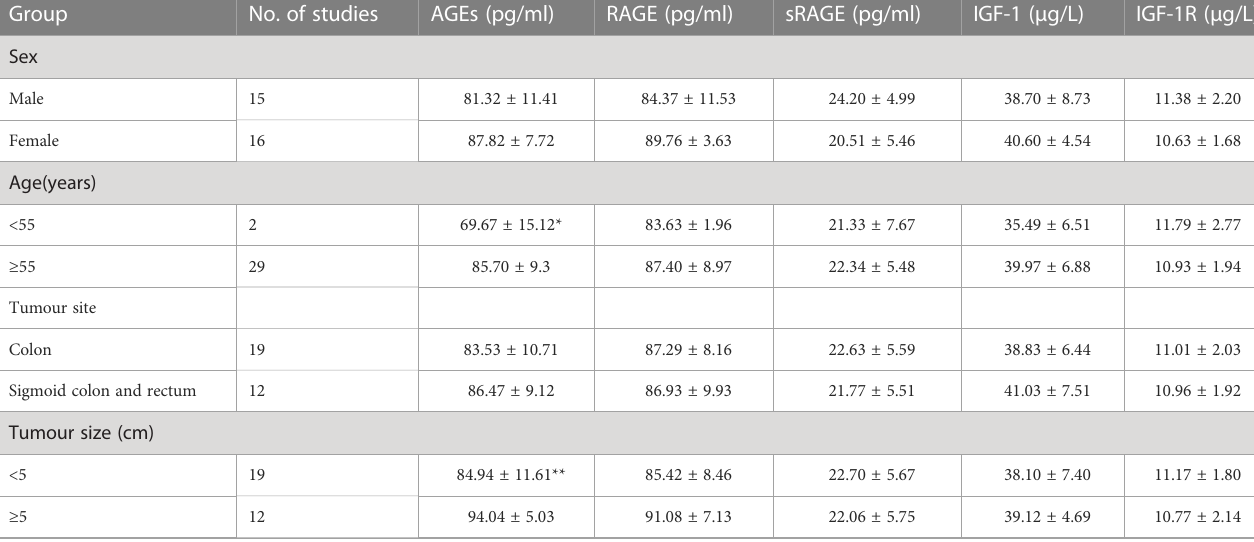
TABLE 2 Comparison of the serum indicators of CRC+T2DM patients with different clinical characteristics.